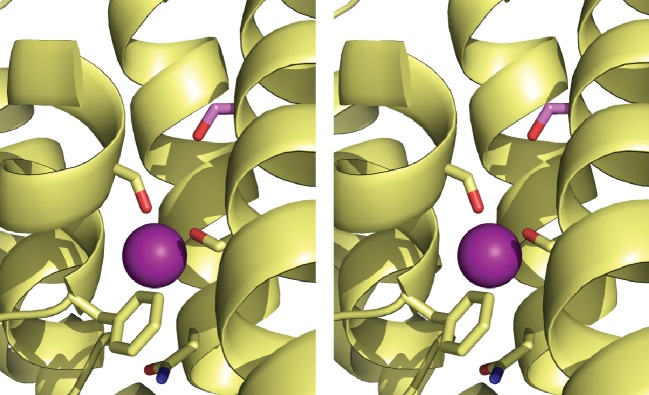
Stereo view of Figure 4b.